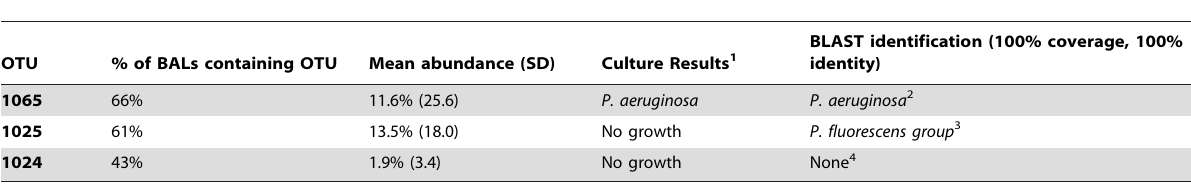
Table 7. Abundance and Identification of Prominent Pseudomonas OTUs in Lung Transplant BALs .